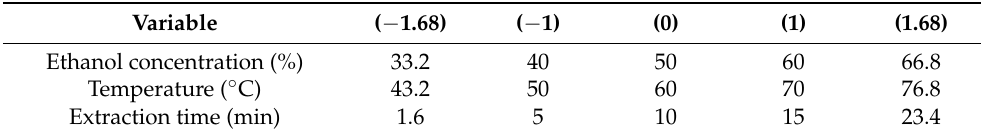
Table 4. Areas of variation of the experimental conditions necessary to improve the extraction of polyphenols from apples using sonication.